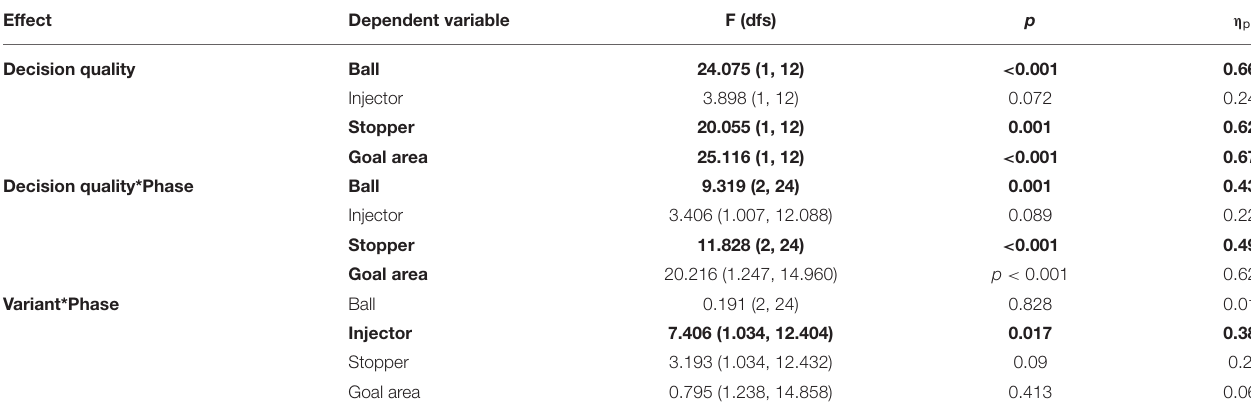
TABLE 2 | Summary of univariate analyses of gaze in defense-dependent strategy as a function of decision quality (optimal vs. less appropriate) and phase of the penalty